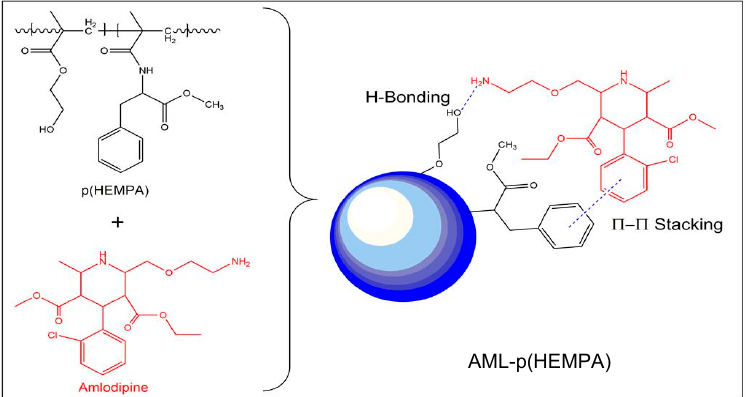
Figure 6. Hypothetic molecular structure of amlodipine loaded AML–p(HEMPA) nanopolymers.